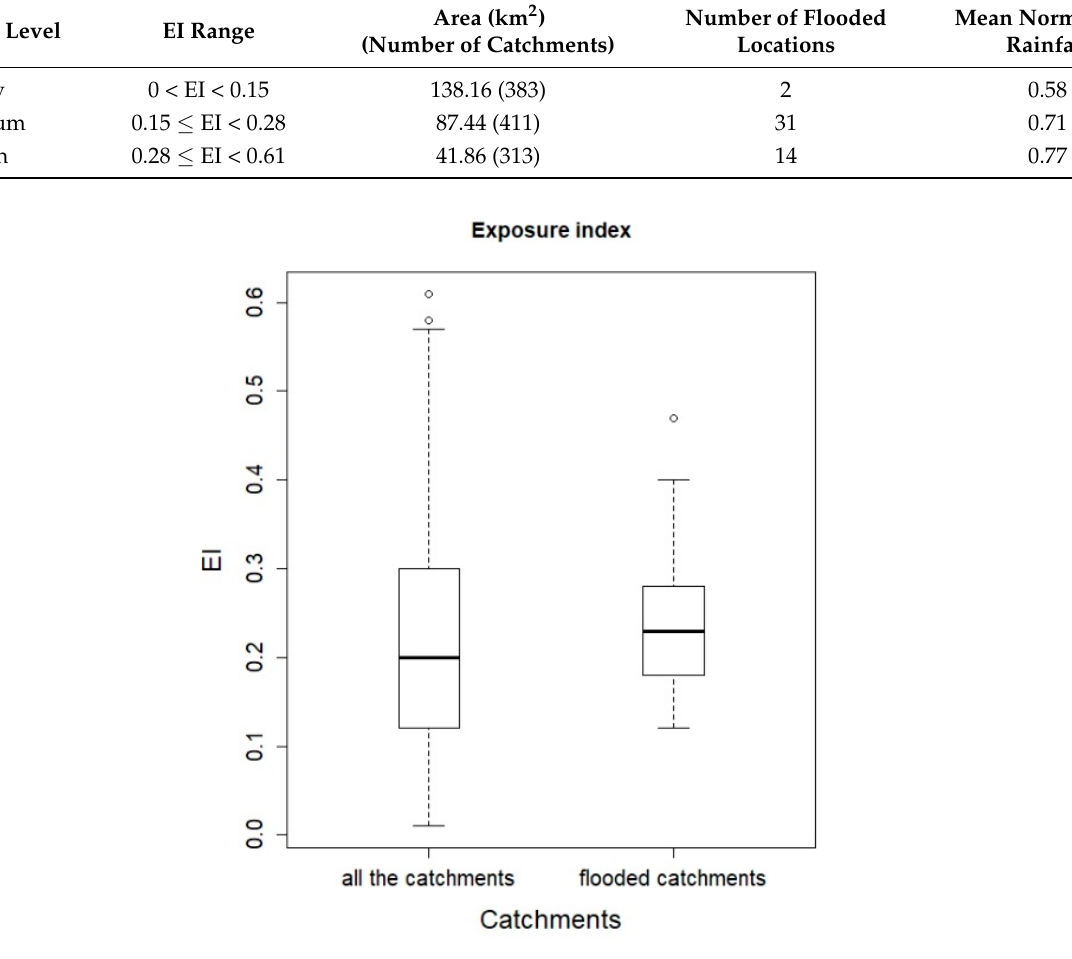
Figure 5. Boxplot of the EI values for all the catchments and flooded catchments.